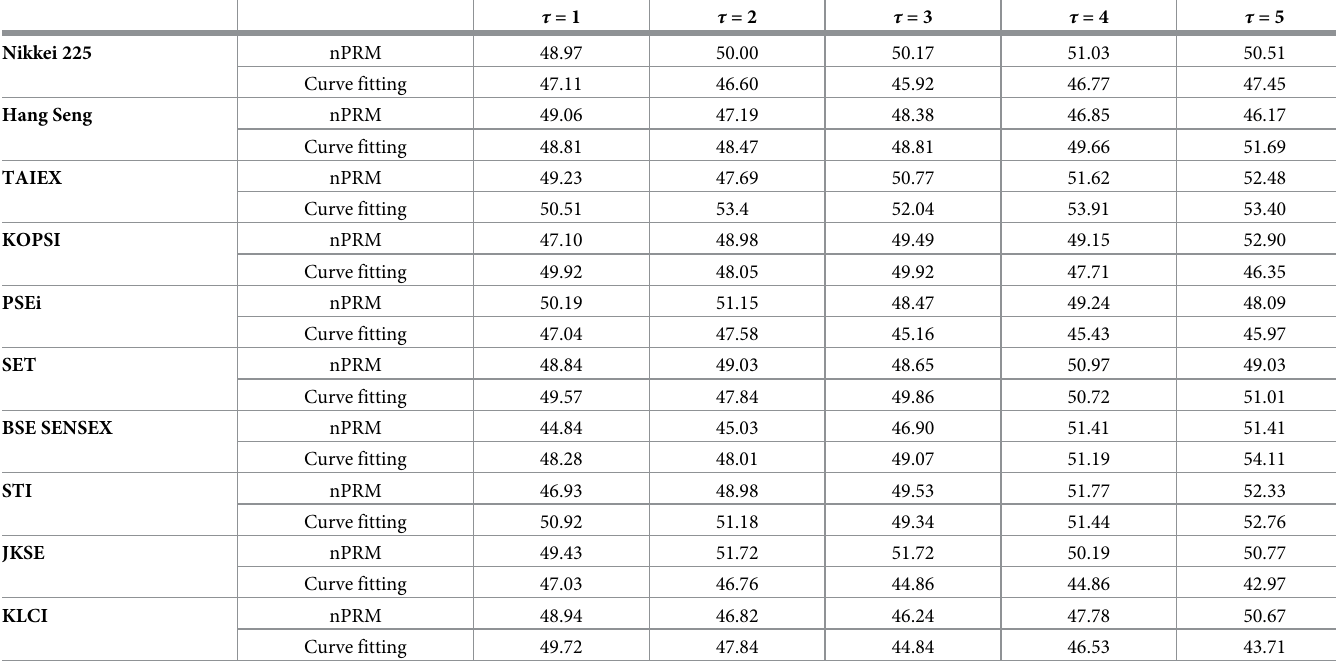
Table 4. Directional Symmetry (DS) (%) for the testing set.